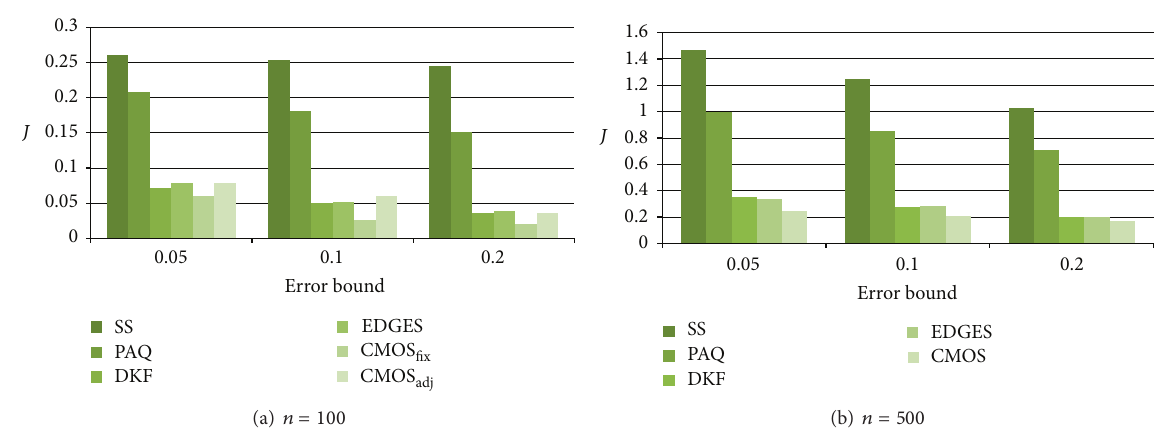
Figure 6: Average energy consumption on EnergyDisperse